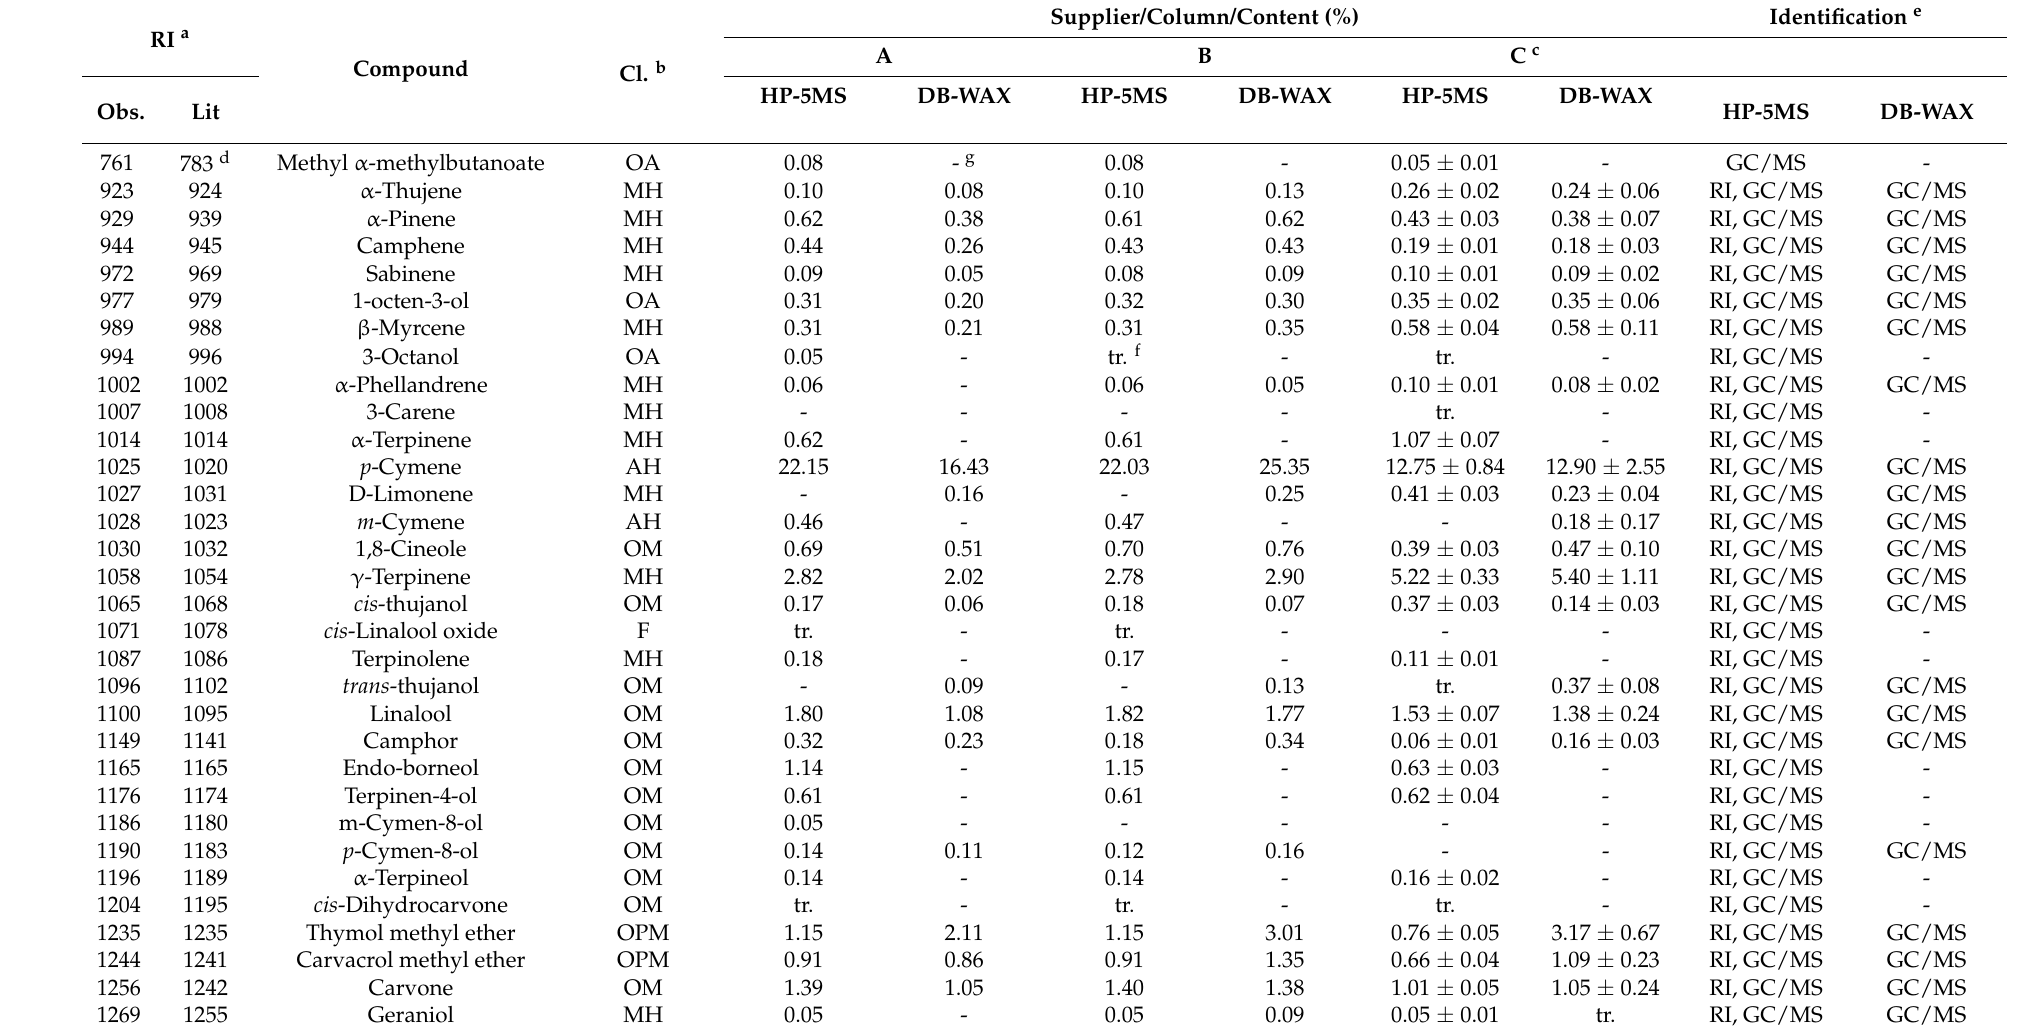
Table 2. Chemical composition of Thymus vulgaris L. essential oils obtained from 3 different commercial